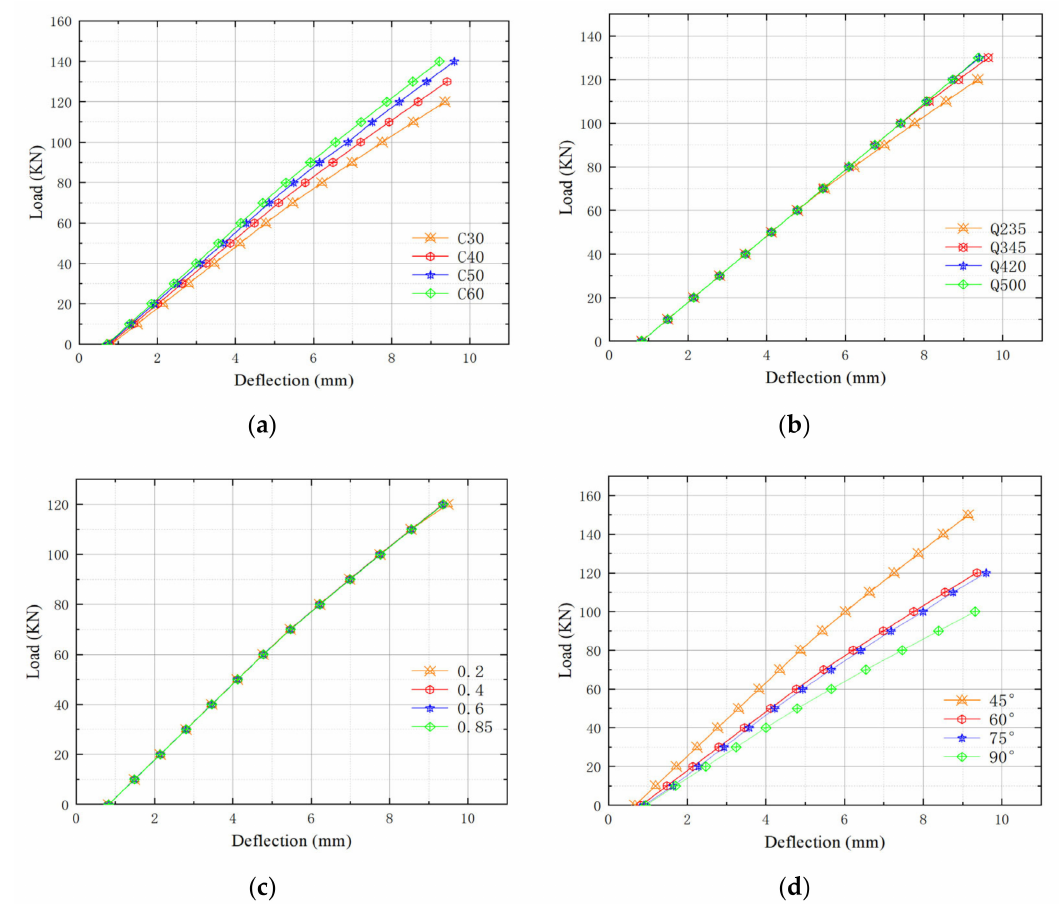
Figure 13. Deflection-load curve of multi-cavity steel-concrete composite beam: ( a ) Different concrete strength; ( b ) Different steel strength; ( c ) Different porosity rate; ( d ) Different angles of internal steel